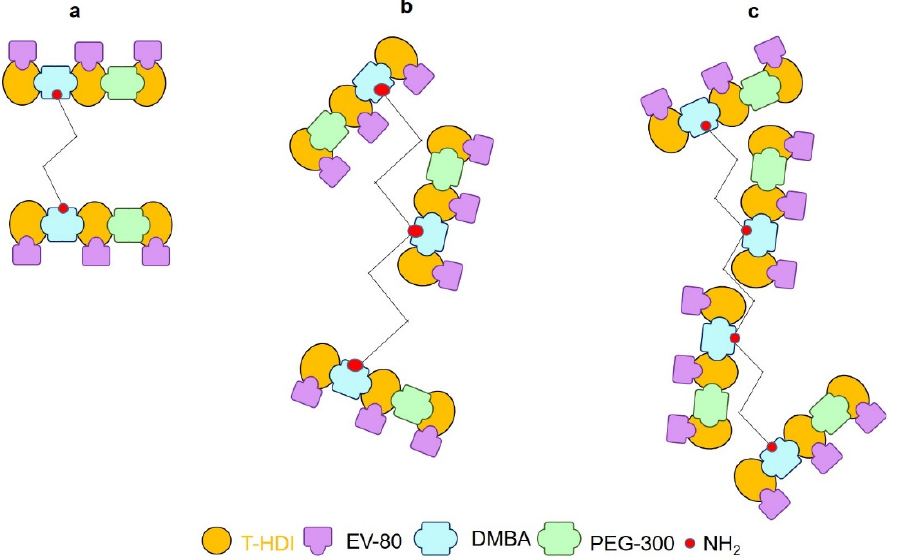
Figure 2. Cross linking density of as prepared ( a ) WPU-g-BTA-A ( b ) WPU-g-BTA-B, and ( c ) WPU-g-BTA-C with different amine chain extenders.